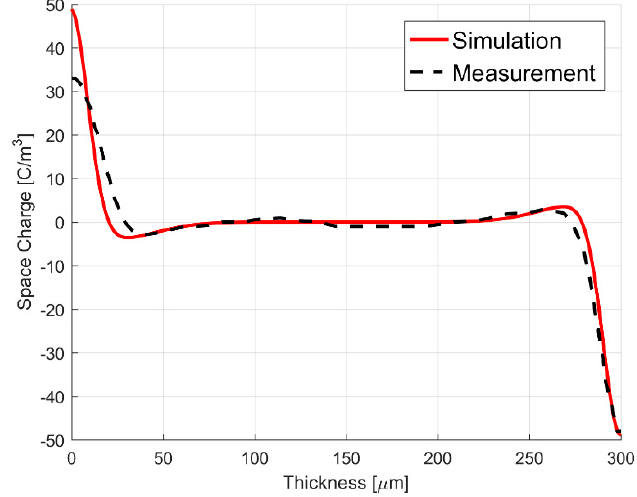
Figure 5. Measured and simulated charge distribution in a planplanar low-density polyethylene (LDPE) insulation [10,21].